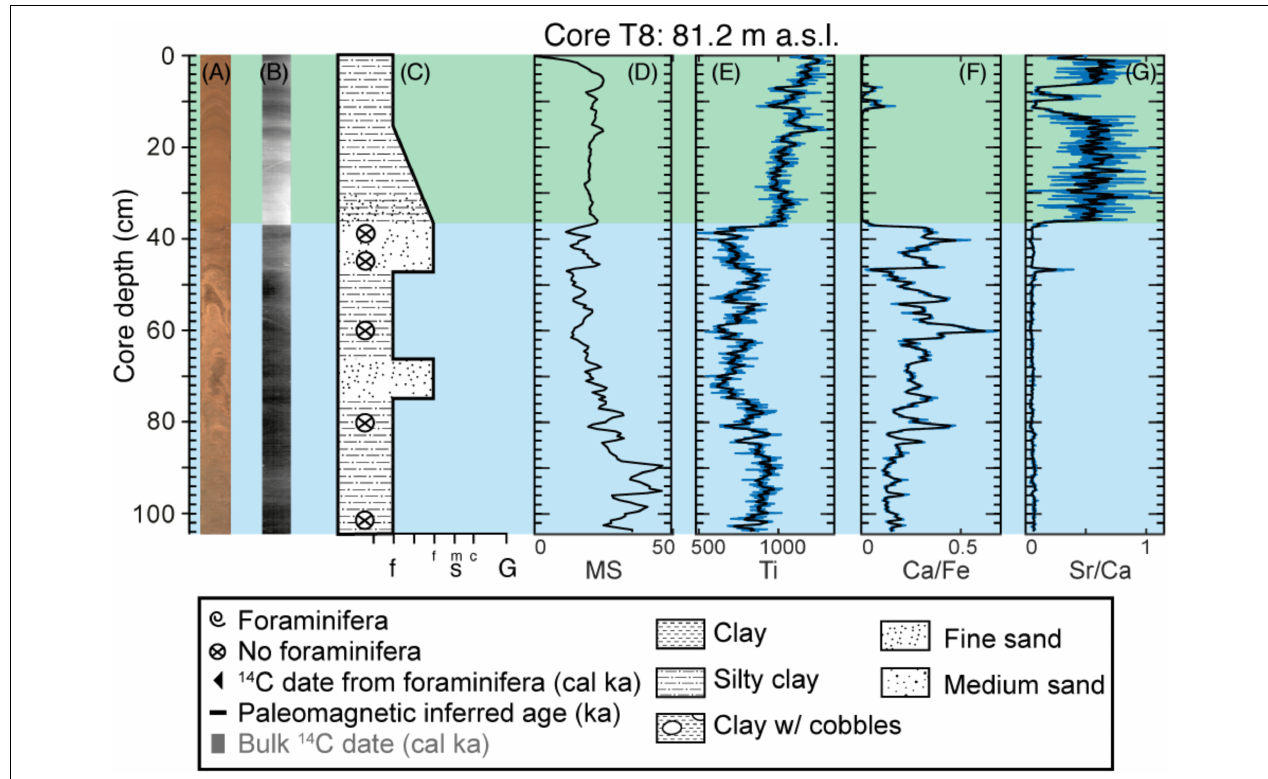
FIGURE 2 | Overview of Core T8. (A) High-resolution image of the core. (B) X-ray image. (C) Lithologic log with grain sizes from fines (clay, silt) to sand and gravel. (D–G) Magnetic susceptibility measurement and content of Ti; Ca to Fe ratio; Sr to Ca ratio. Blue background color indicates marine conditions, green indicates lacustrine. Legend also applies to Figures 3 , 4 , 6 , 7 .